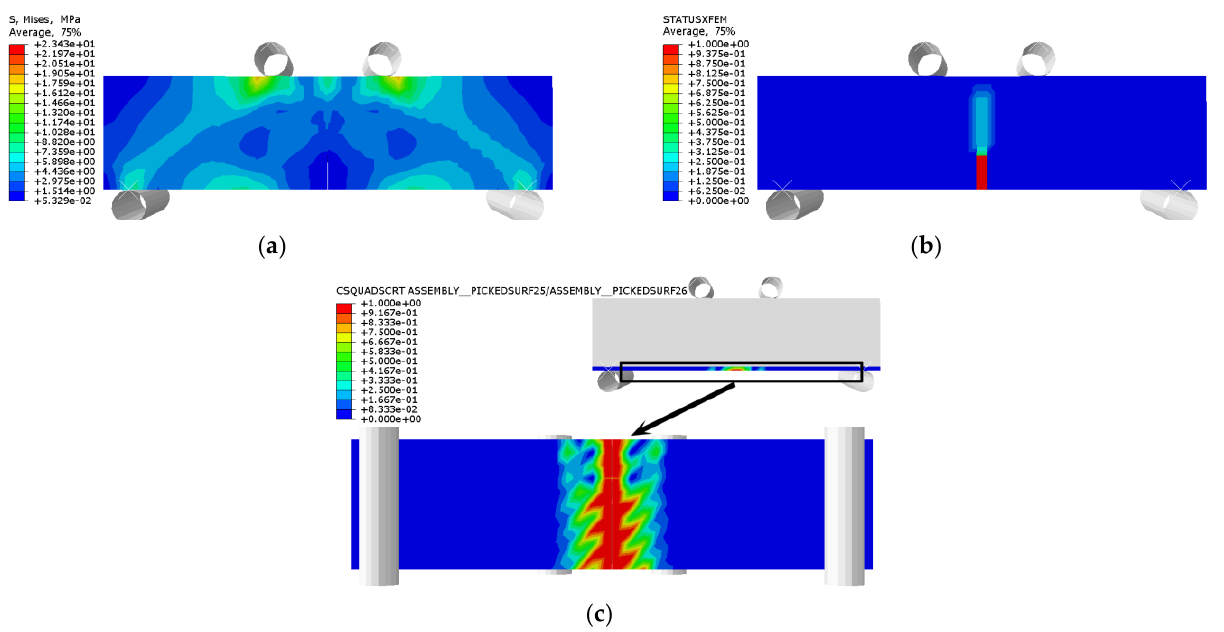
Figure 42. RFSI-400: ( a ) stress nephogram; ( b ) damage nephogram of prefabricated crack; and ( c ) damage nephogram of bonding surface.